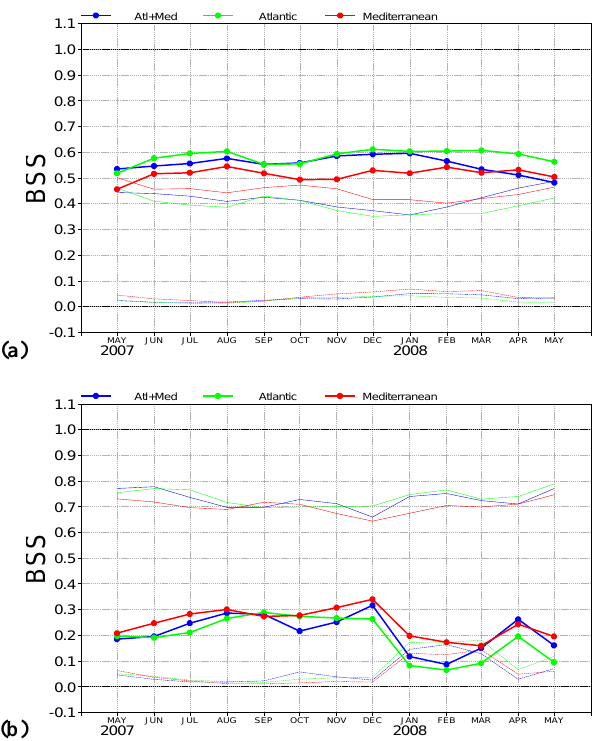
Fig. 5. Brier Skill Score (BSS, thick solid lines) time series as skill measure with respect to sample climatology and its components of reliability (thin dashed lines) and resolution (thin solid lines) for 24- h precipitation over (a) 1mm and (b) 20mm probabilistic forecast from May 2007 to May 2008 over Mediterranean area (red lines), Atlantic area (green lines) and Total Europe area (blue